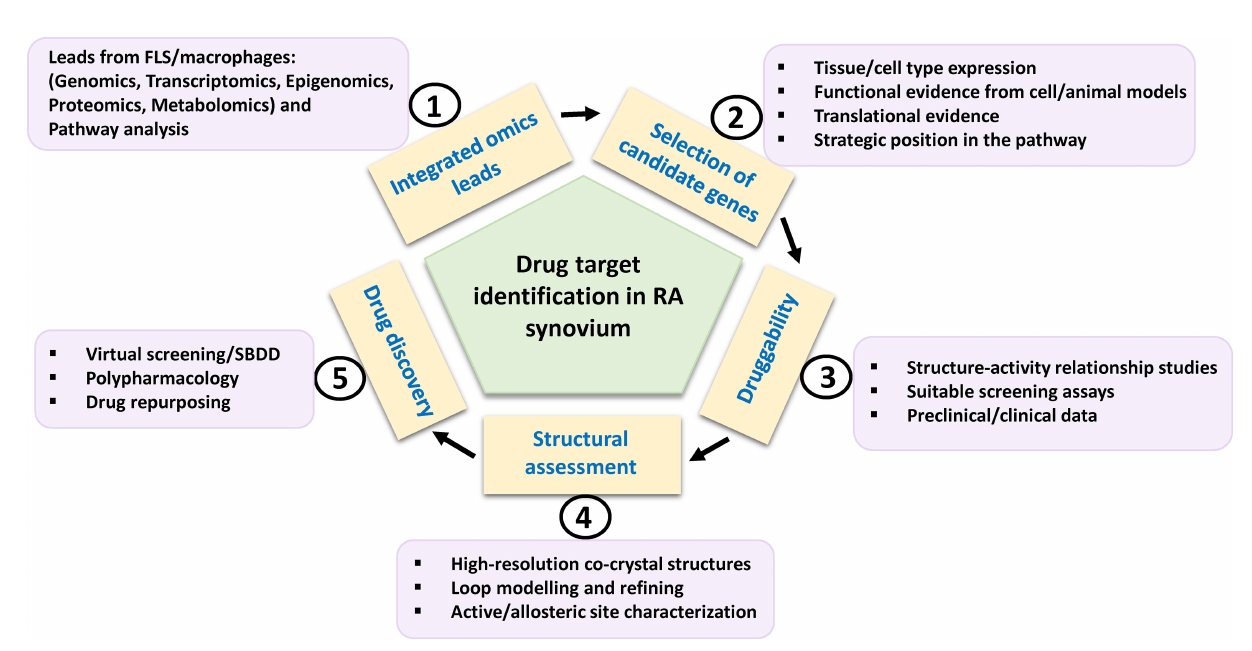
FIGURE 3 | Schema for potential drug target identi fi cation from players in RA synovium. Path from omics-derived candidate genes in FLS and in fl ammatory macrophages to new therapeutics for RA is based on selection of candidate genes on the basis of various factors such as functional evidences. Their amenability to drug discovery may be assessed by preclinical and clinical inhibitor studies. Structural parameters such as availability, re fi ning of functional domain structures and physicochemical properties of binding site residues need to be considered for computational drug discovery involving virtual high throughput screening of chemical library databases or SBDD approach. FLS, fi broblast-like synoviocytes; SBDD, structure-based drug